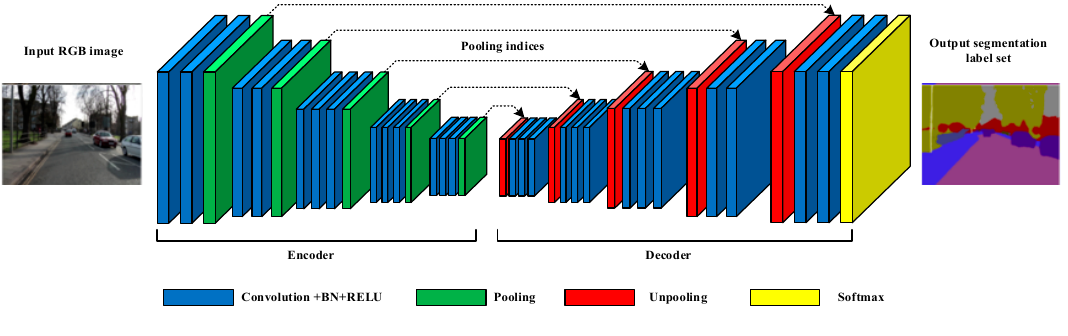
Figure 1. SegNet architecture [16].